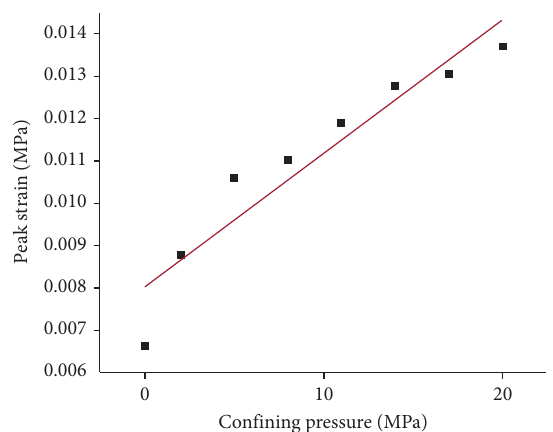
Figure 2: Relationship between peak strain and confining pressure of coal